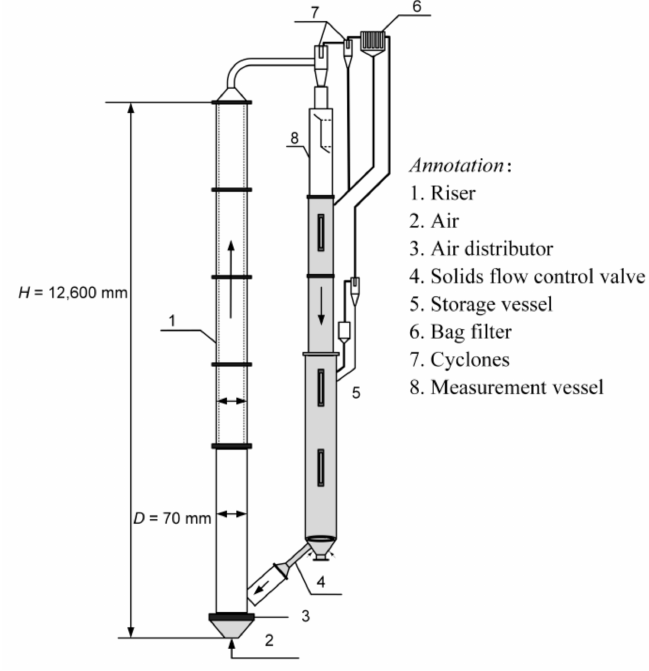
Figure 1. Schematic diagram of the experimental device for the circulating fluidized bed